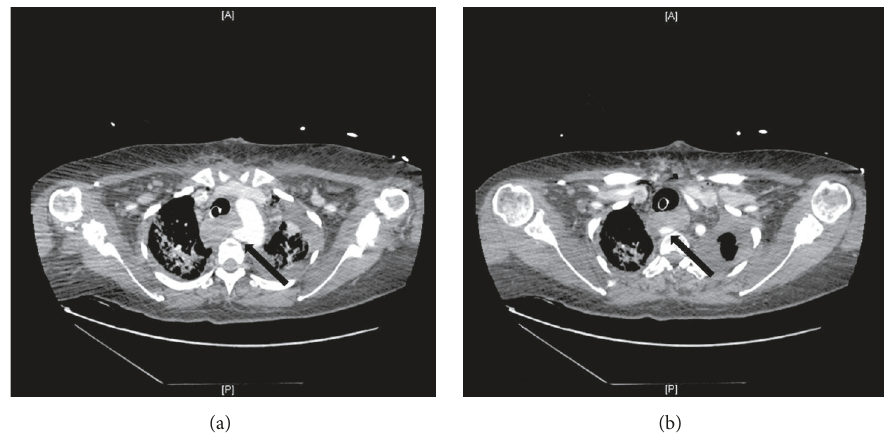
Figure 1: Sequential CT scan images show origin of right subclavian artery from the proximal descending thoracic aorta ((a), black arrow) and coursing posterior to the esophagus ((b), black arrow).